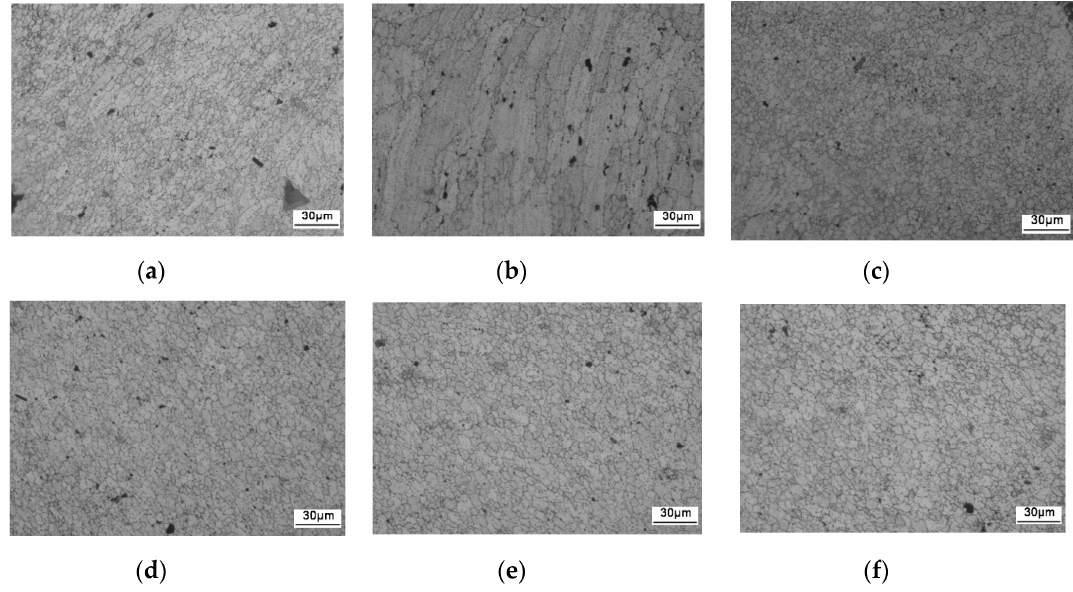
Figure 10. Microstructure of the upper and lower surfaces of the fracture: ( a ) upper surface of area a; ( b ) upper surface of area b; ( c ) upper surface of area c; ( d ) lower surface of area a; ( e ) lower surface of area b; ( f ) lower surface of area c.